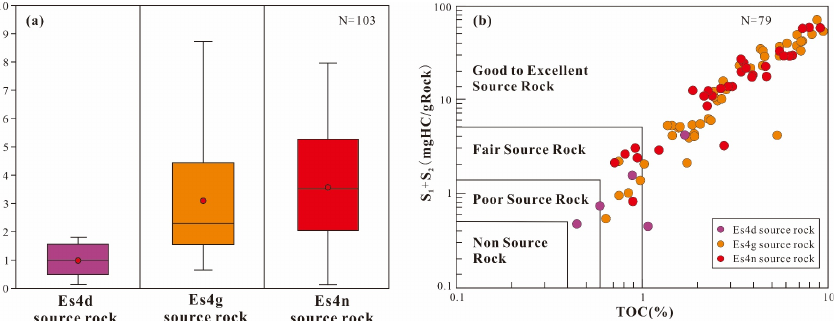
Figure 5. Source rock potential of the Es4d, Es4g, and Es4n source rocks in the Niuxintuo area. ( a ) TOC box plot. ( b ) ( S 1 + S 2 ) vs. TOC plot.